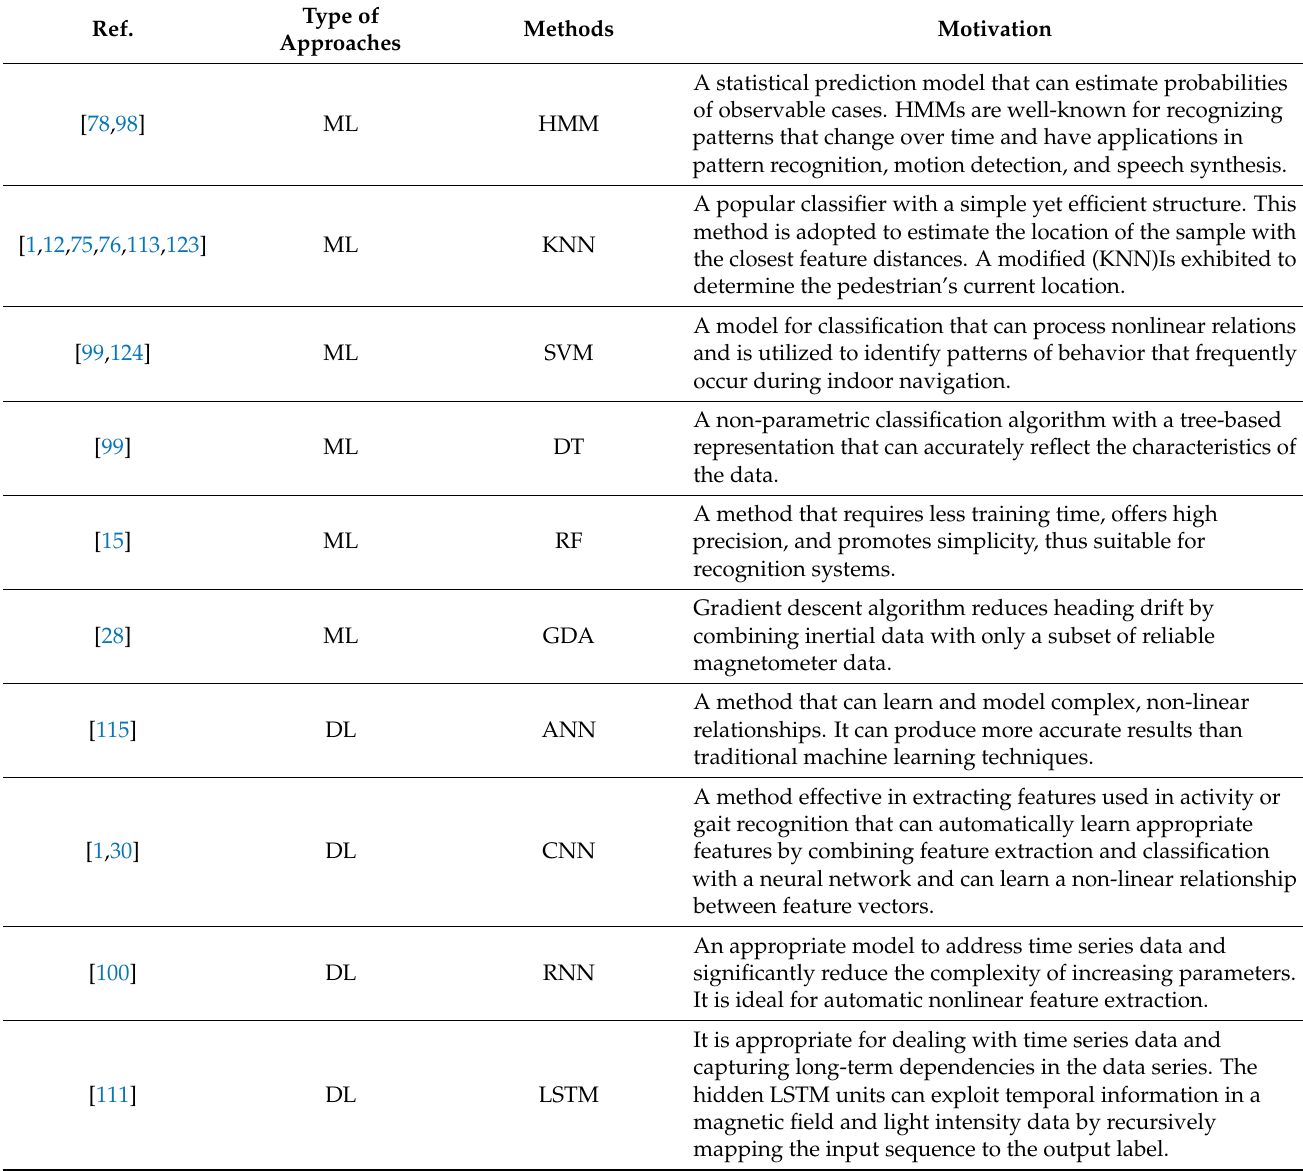
Table 3. Motivations for using the method in previous